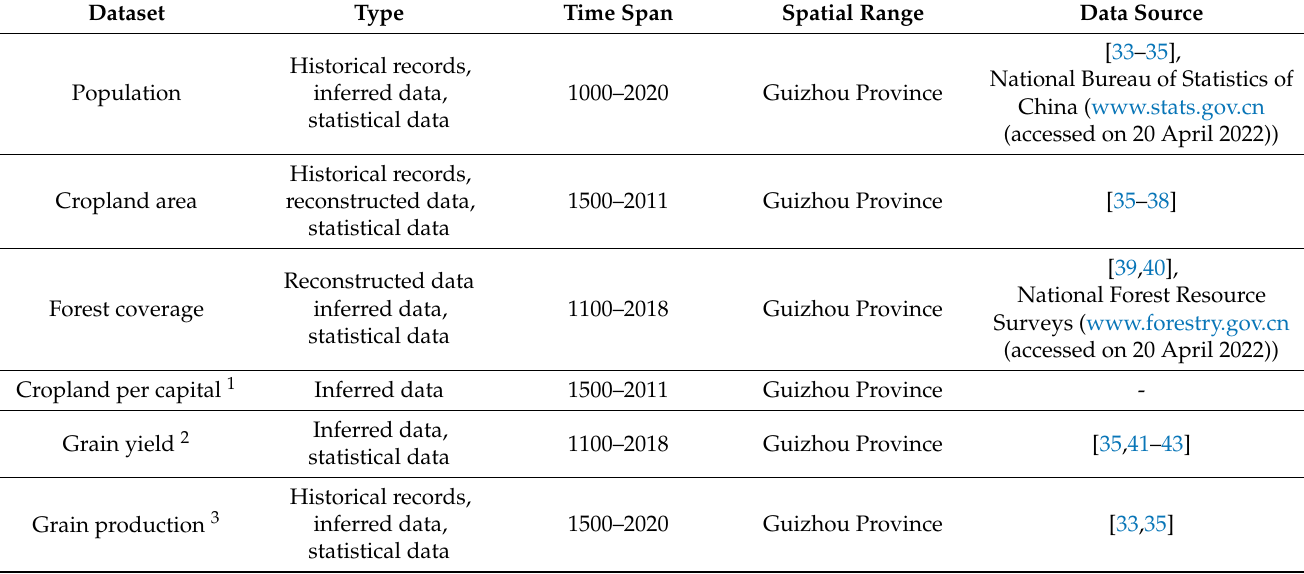
Table 1. Information about the datasets.